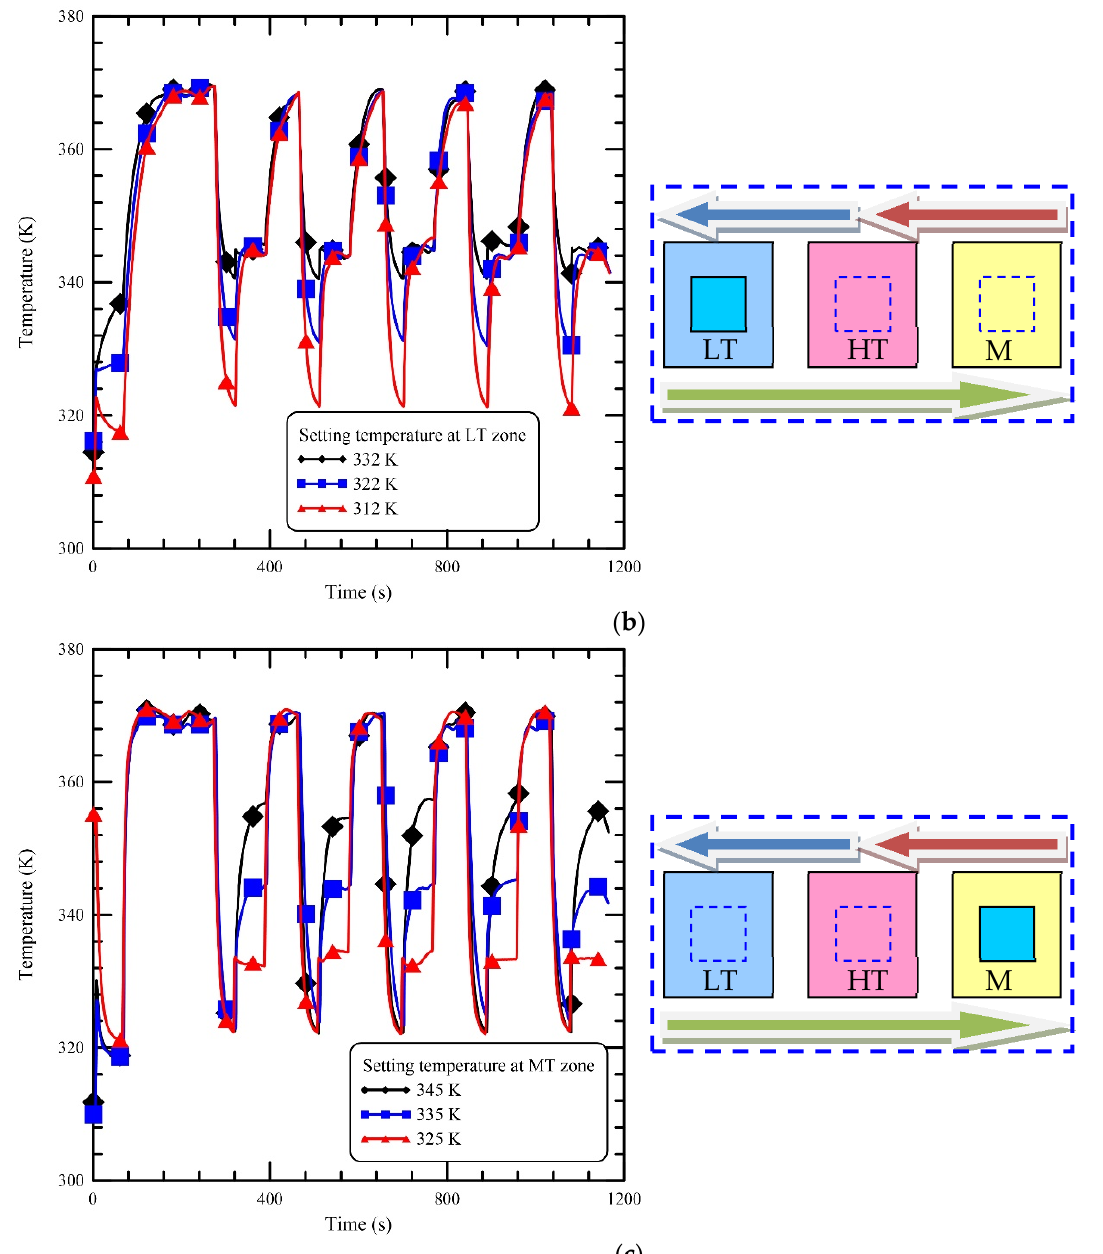
Figure 4. The influence of various heating temperatures of aluminum blocks on the reaction chamber temperatures. ( a ) The setting temperatures of the HT zone are 363 K, 353 K, and 343 K. ( b ) The setting temperatures of the LT zone are 332 K, 322 K, and 312 K. ( c ) The setting temperatures of the MT zone are 345 K, 335 K, and 325 K.